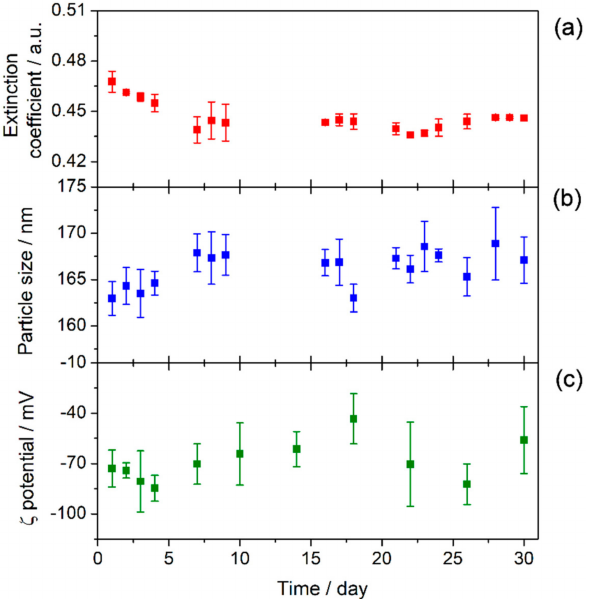
Figure 8. Stability of TiO 2 -nanofluid measured for 30 days: ( a ) extinction coefficient at λ = 550 nm, ( b ) particle size, and ( c ) ζ potential.